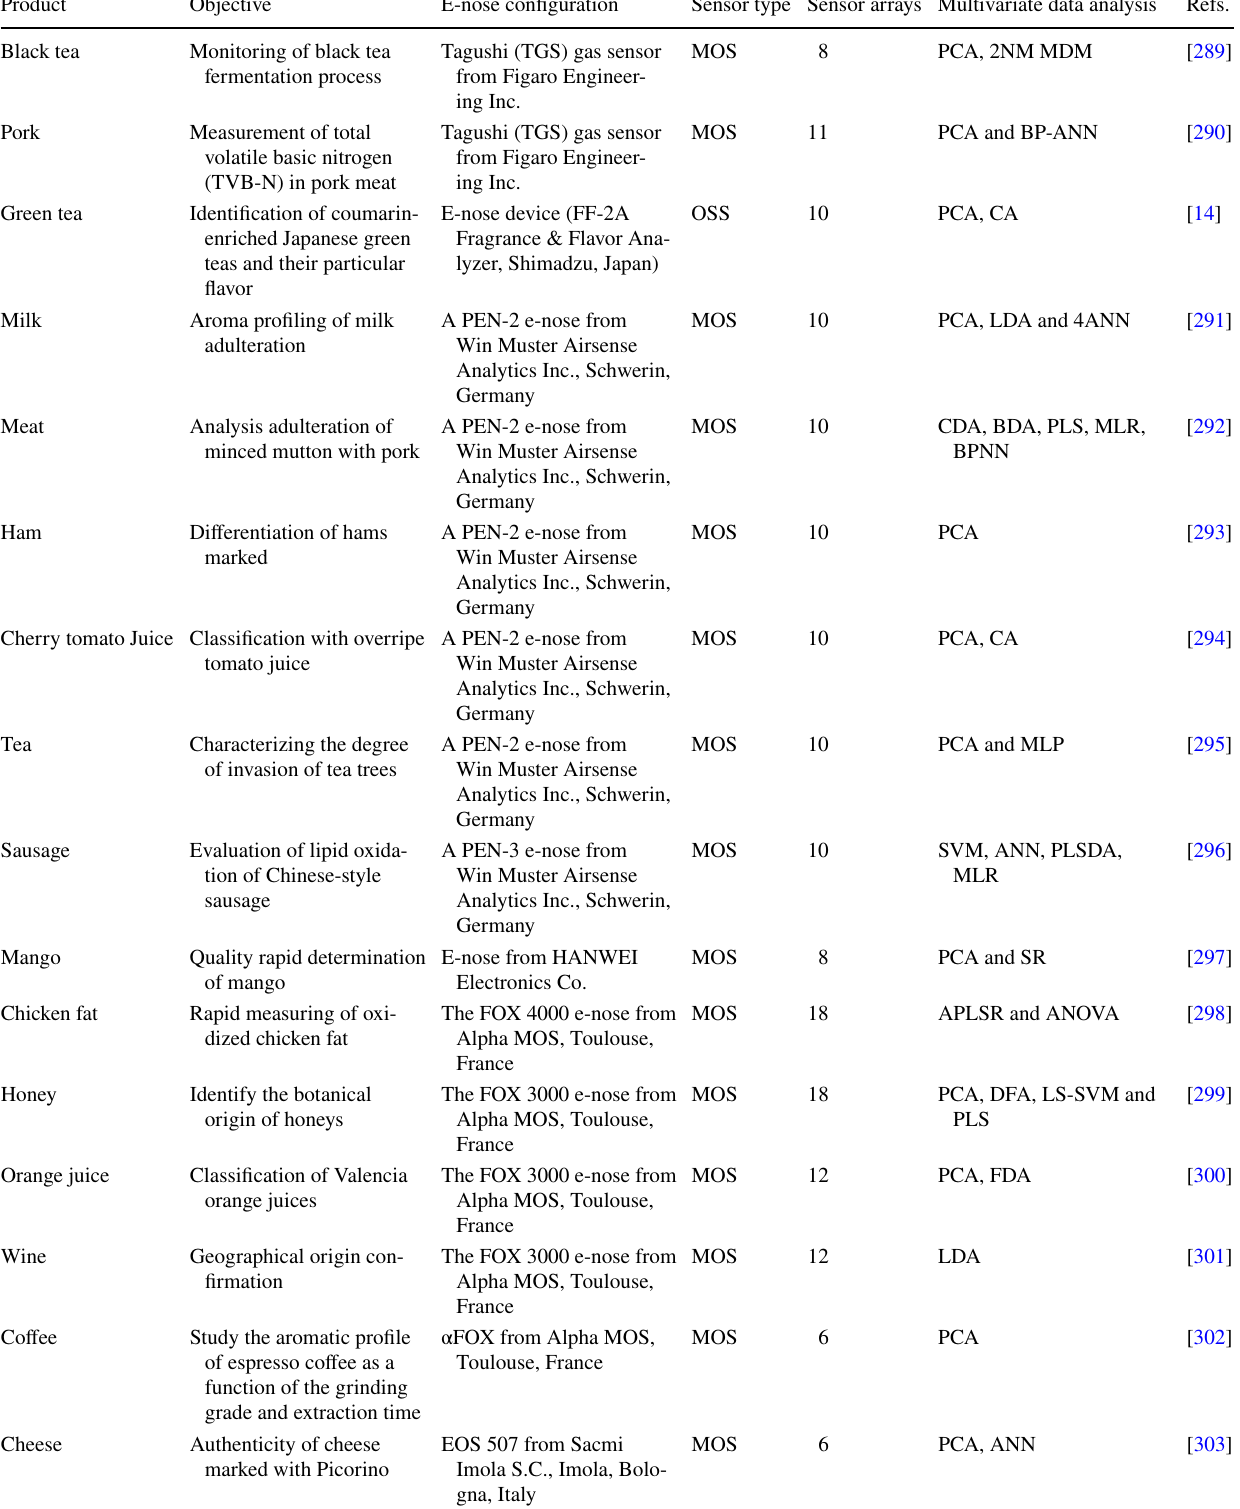
Table 9 Applications of electronic nose for monitoring foods and beverage